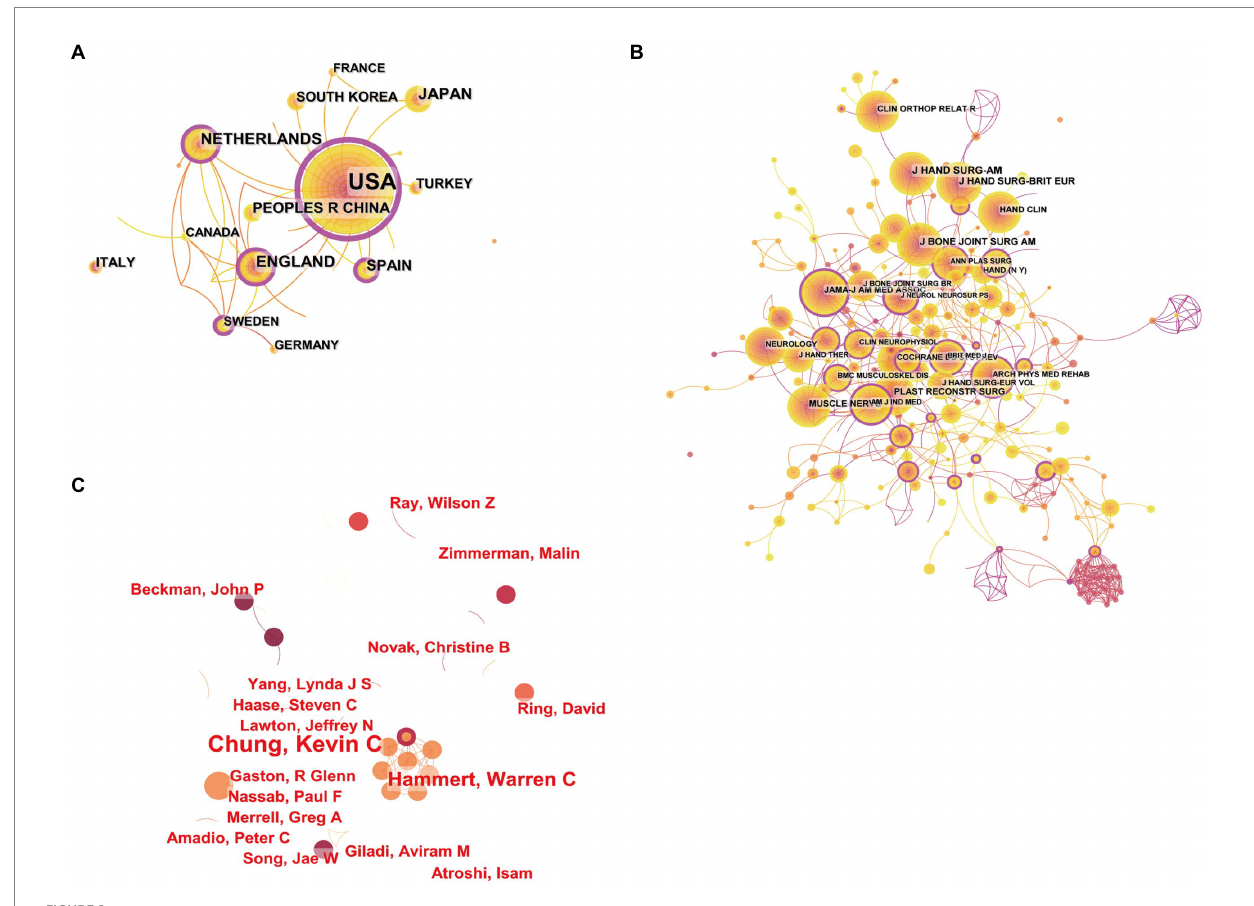
FIGURE 2 Analysis of collaborative networks on surgical treatment of carpal tunnel syndrome from 2003 to 2022. (A) The collaborative network of National/ regions. (B) The collaborative network of authors. (C) The collaborative network of